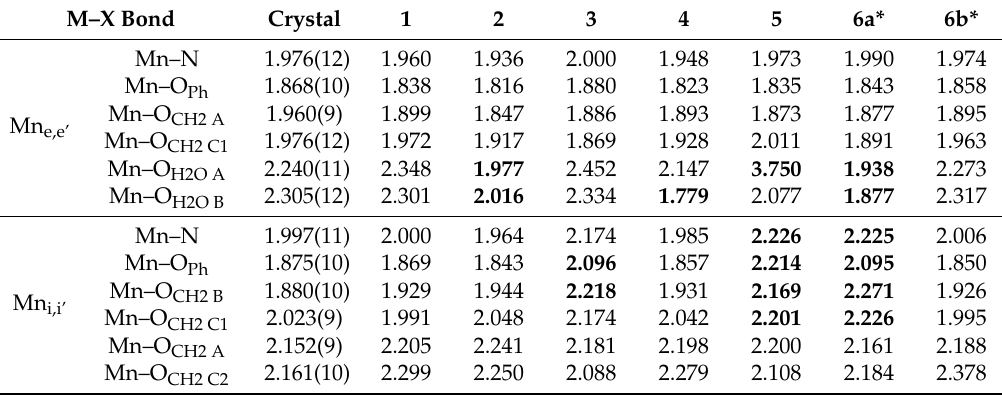
Table 6. Geometric parameters of the first coordination sphere of Mn in the models optimized with B3LYP/6-31g(d)/LANL2DZ. Values in Å.